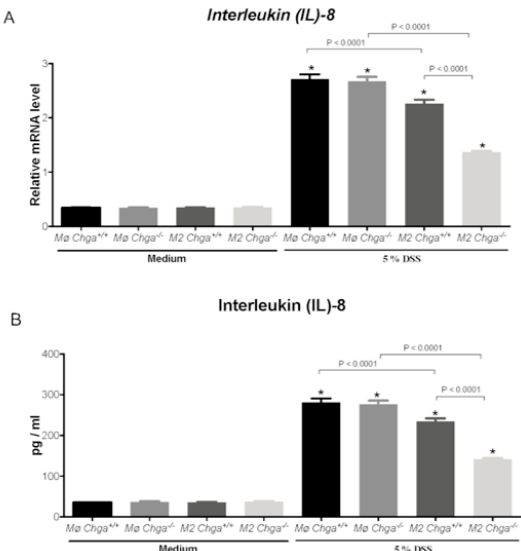
Figure 6. Chromogranin-A ( Chga )-deficient alternatively activated macrophages (M2)-conditioned supernatant reduces interleukin (IL)-8 mRNA expression and release in dextran sulphate sodium (DSS)-stimulated Caco-2 epithelial cells. Caco-2 cells were seeded at 3 × 10 5 cells/well onto tissue culture plates and treated with 2 mL of non-conditioned supernatant (Mo) or M2-conditioned supernatant of wild-type ( Chga +/+ ) and Chga -knockout ( Chga − / − ) for 24 h. Then cells were challenged with 5% DSS or regular medium for an additional 24 h. ( A ) IL -8 mRNA expression were quantified by RT-qPCR; ( B ) IL-8 releases were quantified by ELISA. One-way ANOVA followed by Tukey’s multiple comparison tests. Each value represents the mean ± SEM, n = 6–9. * p < 0.05 refers to significance compared with medium groups.